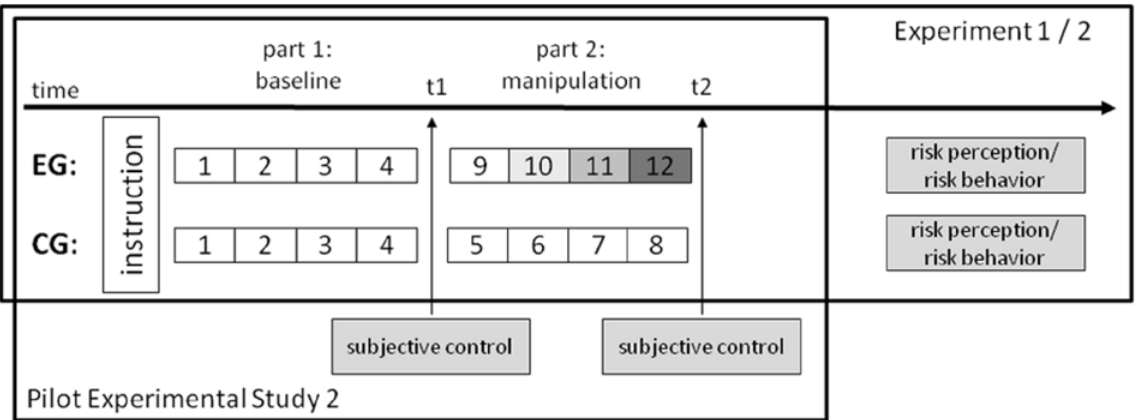
Fig 2. Design of Pilot Experimental Study 2 and Main Experimental Studies 1 and 2. Pilot Experimental Study 2 tested the experimental computer- based problem-solving paradigm that included 12 different task patterns for inducing difficulty-related loss of control. In a one-factor pre-post design the experimental (EG) and control groups (CG) were compared using subjective control questionnaires following the baseline (t1) and manipulation (t2) parts of the experiment. Main Experimental Studies 1 and 2 applied the same computer-based problem-solving paradigm to investigate the effects of loss of control on risk perception and risk behavior,